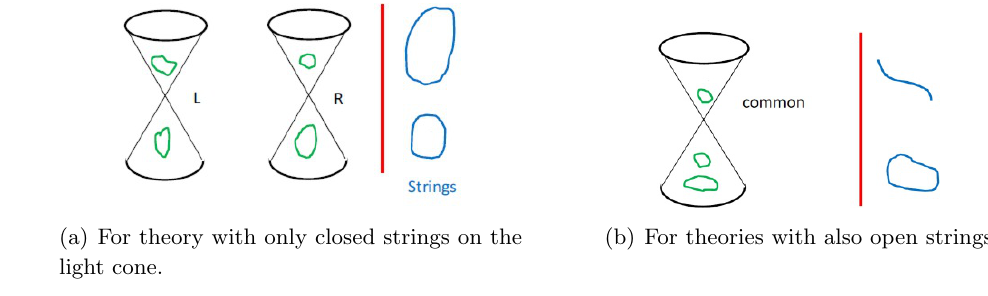
Figure 2 . Chains of objects on the light cone in the 25 + 1 dimensional Minkowski space. (a) is depicted on the closed strings in terms of the left and right movers; (b) The left and right movers of the open and closed strings are written together.